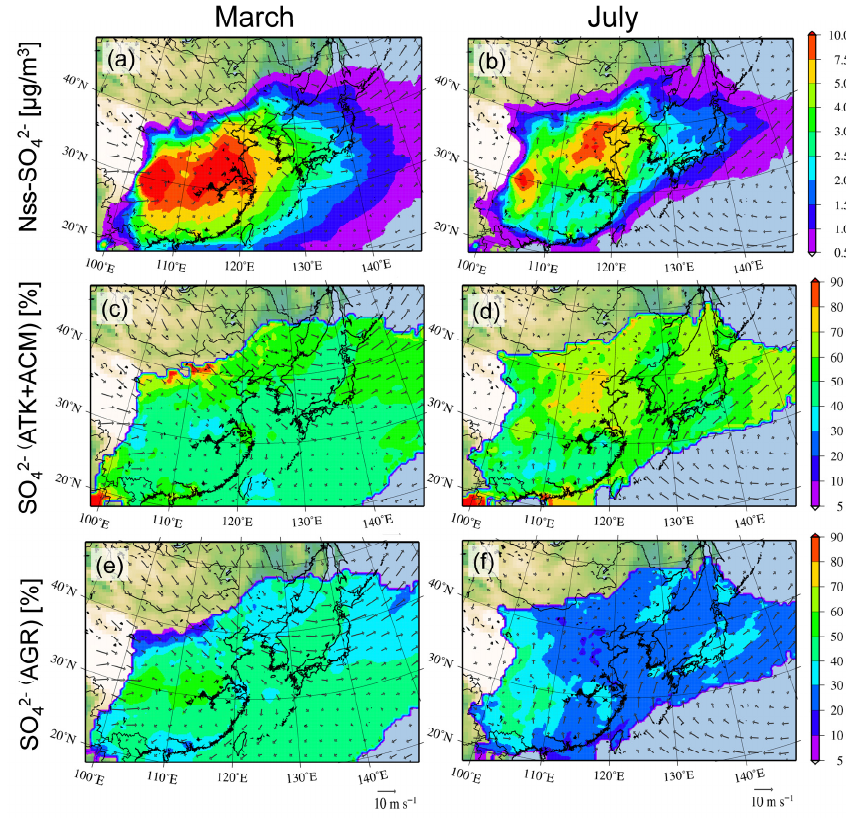
Figure 7. Spatial distributions of mean concentrations and mixing types of sulfate in the lower atmosphere ( < ∼ 1000m) in (left) March and (right) July: (a–b) sulfate concentration (µmm − 3 ) , (c–d) fraction of sulfate mixed with non-light-absorbing particles (ATK + ACM) (%), and (e–f) fraction of sulfate mixed with light-absorbing particles (AGR) (%).